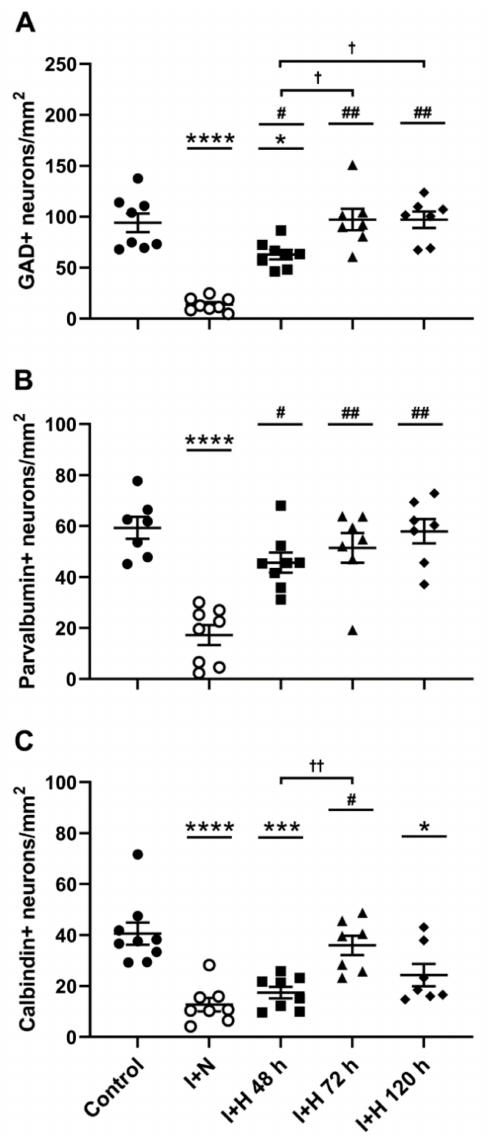
Figure 3. Interneuron survival in the parasagittal cortex in sham control (control), ischemia + normothermia (I + N), ischemia + hypothermia 48 h (I + H 48 h), ischemia + hypothermia 72 h (I + H 72 h), and ischemia + hypothermia 120 h (I + H 120 h) groups at 7 days recovery. Data show densities (cells/mm 2 ) of ( A ) glutamate decarboxylase (GAD) + , ( B ) parvalbumin + , and ( C ) calbindin + interneurons and are presented as mean ± standard error of the mean. Sham control group (closed circles; GAD + , n = 8; parvalbumin + , n = 7; and calbindin + , n = 9). I + N group (open circles; GAD + , n = 8; parvalbumin + , n = 8; and calbindin + , n = 8). I + H 48 h group (closed squares; GAD, n = 8; parvalbumin, n = 8; and calbindin, n = 8). I + H 72 h group (closed triangles; GAD + , n = 7; parvalbumin + , n = 7; and calbindin + , n = 7). I + H 120 h group (closed diamonds; GAD + , n = 7; parvalbumin + , n = 7; and calbindin + , n = 7). * p < 0.05, *** p < 0.001, and **** p < 0.0001 ischemia + normothermia vs. control; # p < 0.001 and ## p < 0.0001 ischemia + hypothermia vs. ischemia + normothermia; † p < 0.05 and †† p < 0.01 comparisons between ischemia + hypothermia